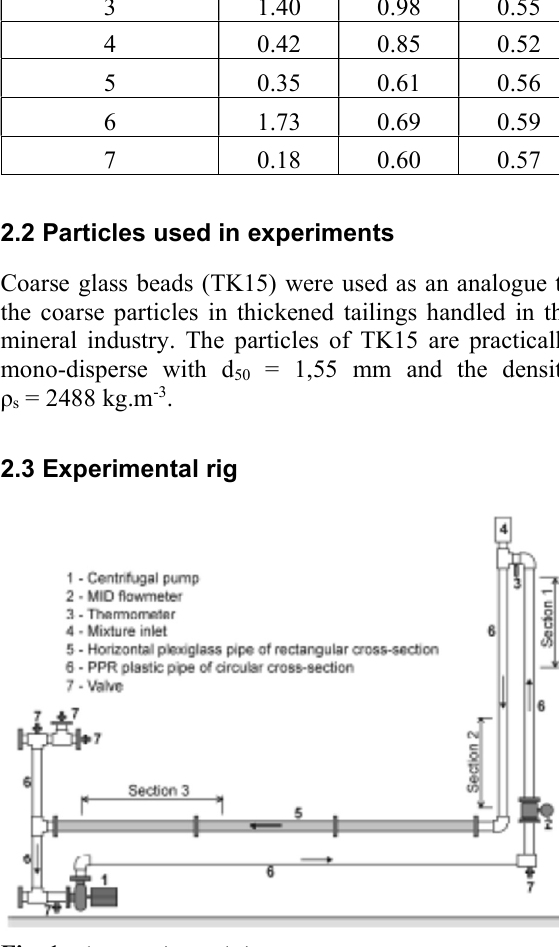
Fig. 1 . The experimental rig.